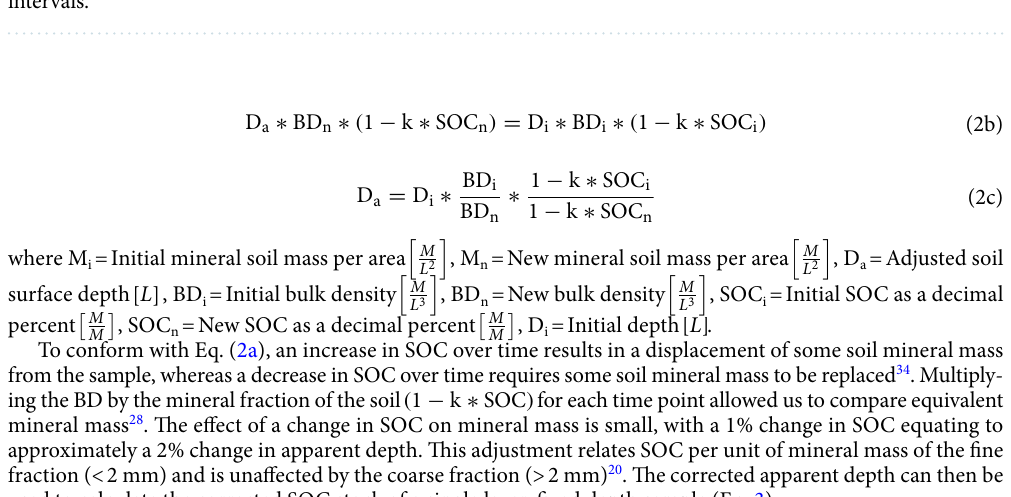
Figure 2. Flow chart of the definition, sampling, and SOC stock correction for a theoretical data set at time points t0, t1, and t2 for scenarios s1 with linear distributions of BD and SOC and s2 with a linear increase in BD and exponential decrease in SOC with depth. Scenario s2 is sampled at ( a ) 10 cm, ( b ) 15 cm, and ( c ) 30 cm